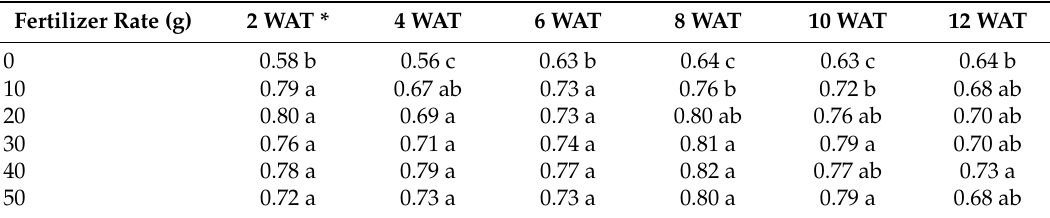
Table 1. Normalized Di ff erence Vegetation Index values for a plant in a single pot with di ff erent rates of fertilizer at di ff erent weeks after fertilizer treatment in Justicia brandegeana . Fertilizer Rate (g) 2 WAT *